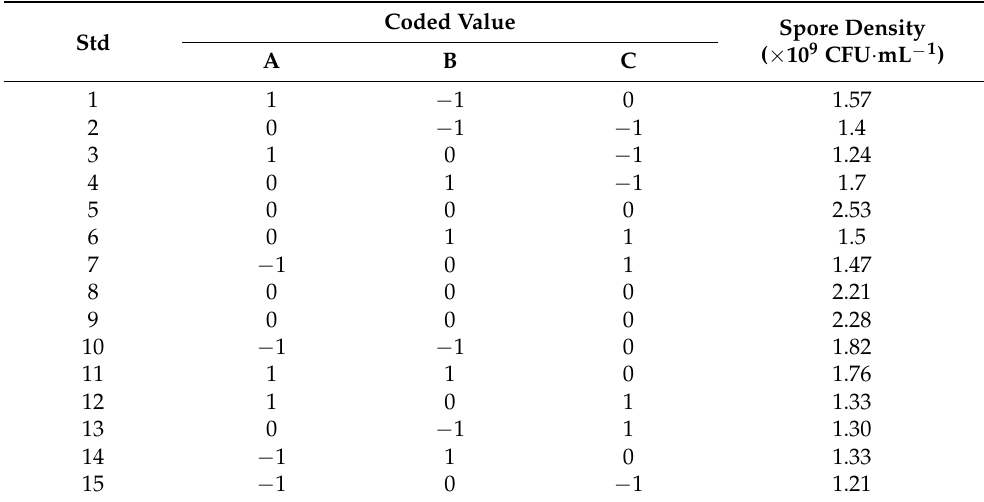
Table 2. Central composite design of actual factors and responses based on actual values.